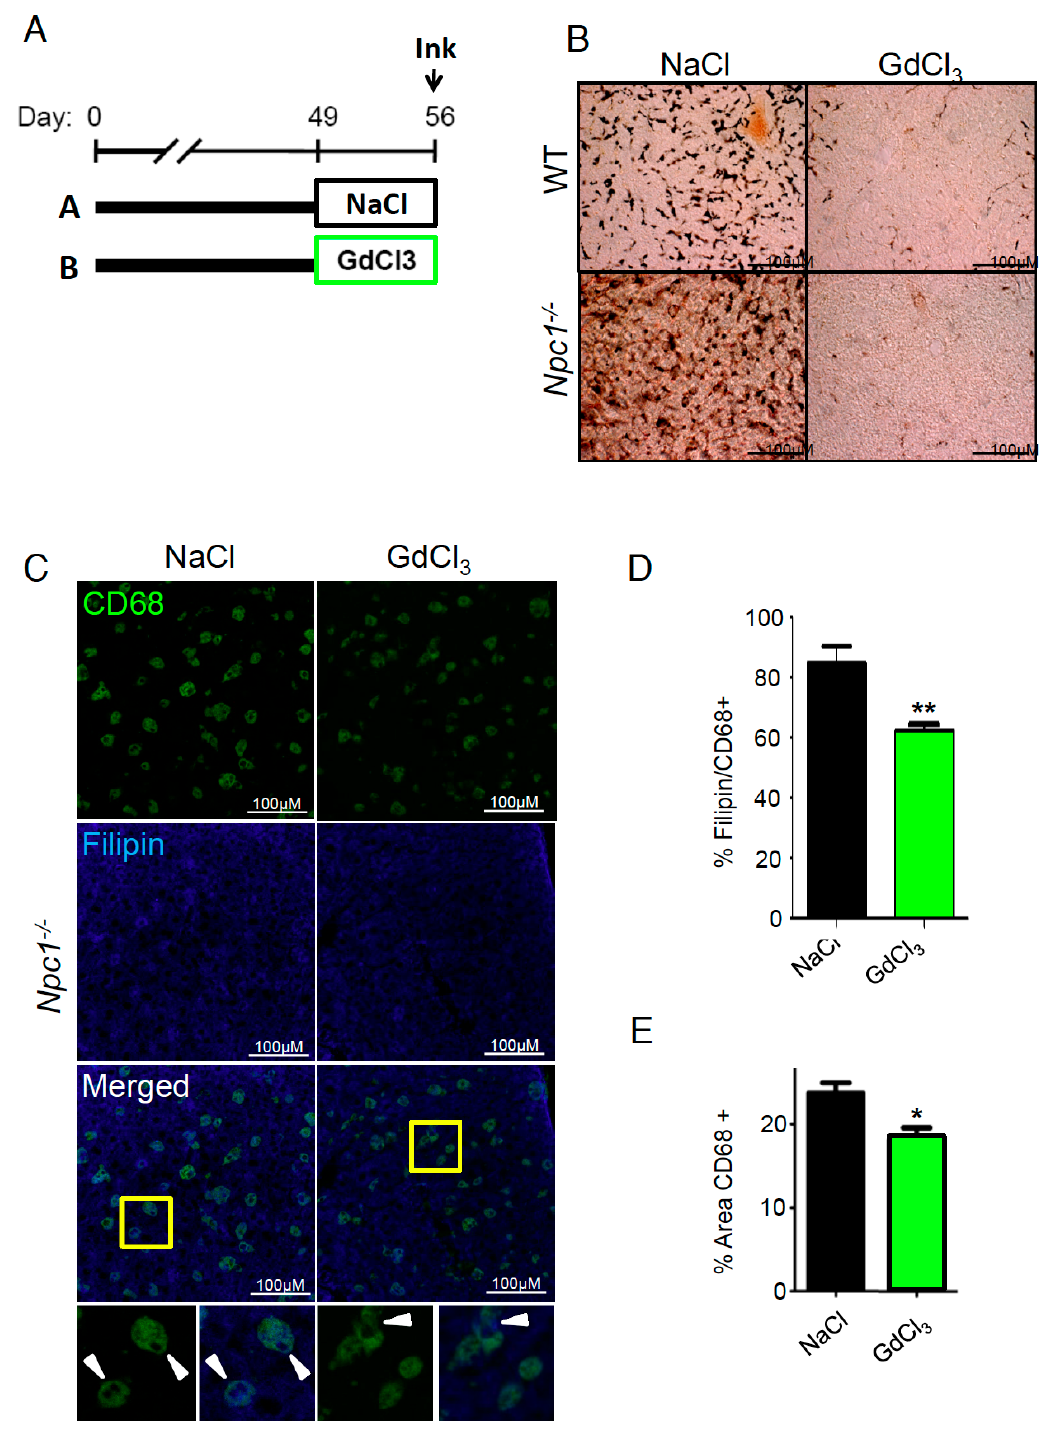
Figure 3. GdCl 3 treatment decreases Kupffer/foam cells endocytosis. ( A ) Timeline of the duration and age of GdCl 3 treatment in mice. The time of India ink injection is indicated (postnatal day (P)56). As a control, animals were treated with a saline solution (NaCl). ( B ) India ink deposits were visualized with light microcopy. Scale bars are 100 µm. ( C ) CD68 and filipin staining in GdCl 3 - and NaCl-treated Npc1 − / − mice. Scale bars are 100 µm. Bottom images show merged CD68 and filipin staining and the areas marked with yellow squares were magnified below. The arrowheads show cells positive for CD68 and filipin. ( D ) Quantification of % filipin/CD68 positive cells. ( E ) Quantification of the area covered by CD68 cells.